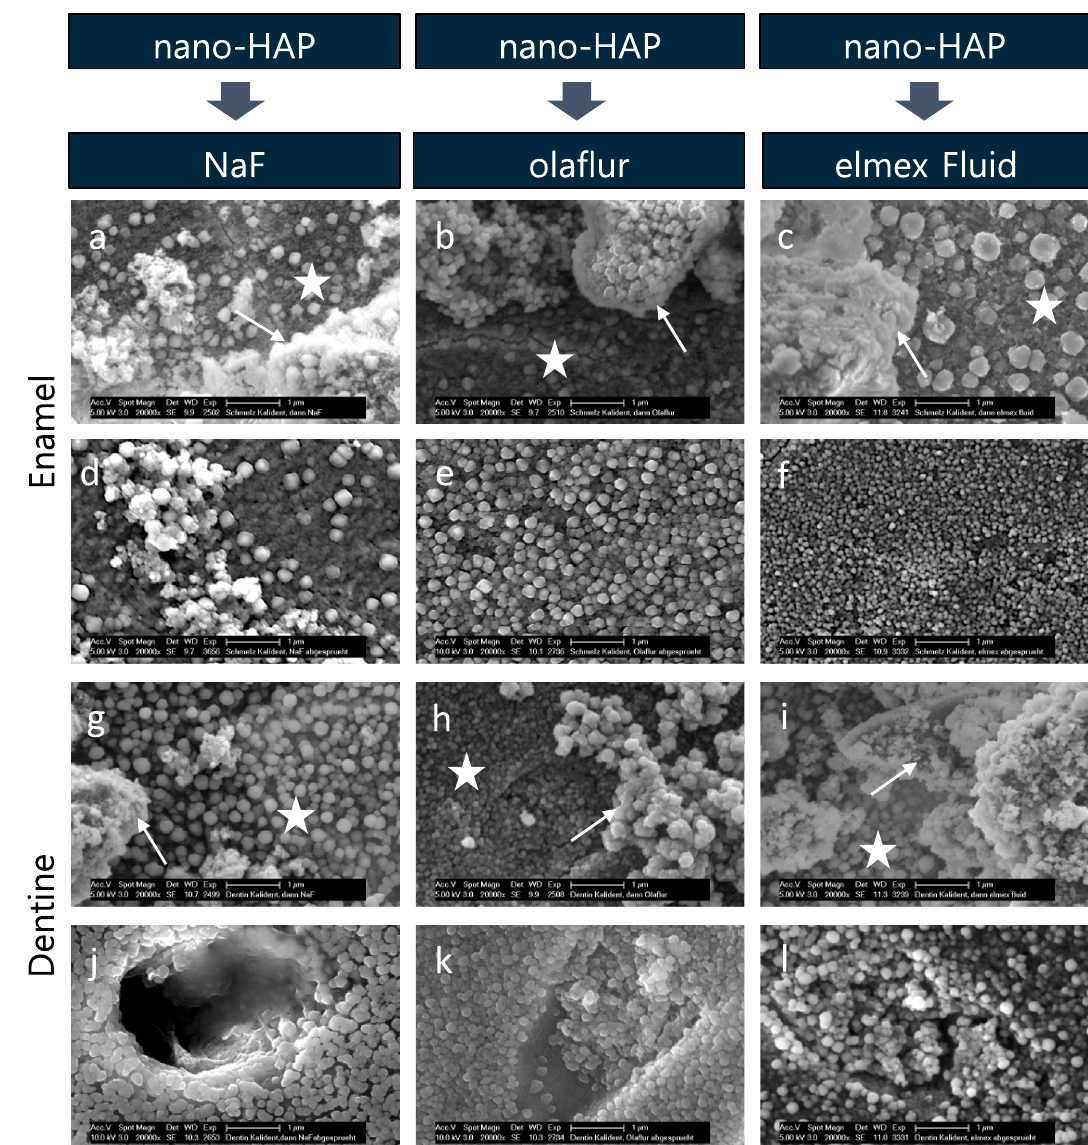
Figure 7. SEM figures at 20,000-fold magnification of enamel ( a–f ) and dentine ( g–l ) samples after 5 min primary incubation in aqueous nano-HAP solution and 5 min secondary incubation in sodium fluoride ( a,g ), olaflur ( b,h ), elmex Fluid ( c,i ) and subsequent 20 s spraying with the multifunctional syringe ( d–f,j–l ). The images reveal an inhomogenous coverage of the fluoridated surface with nano-HAP particles of different size and shape. White asterisks mark the surface masked with globules. White arrows point to accumulated nano- HAP particles masked with calcium fluoride globules. After spraying, a surface homogenously covered with globular precipitates is visible. The nano-HAP particles are completely washed off. Nano-HAP hydroxyapatite nanoparticles, NaF sodium